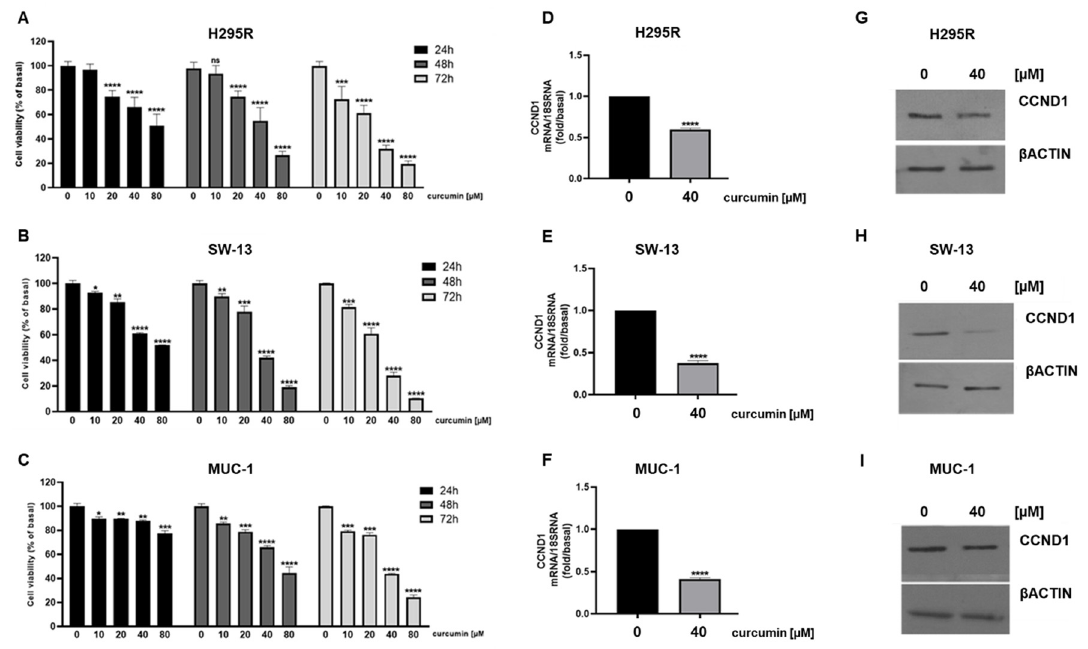
Figure 1. Curcumin reduces ACC cell viability. H295R ( A ), SW ‐ 13 ( B ) and MUC ‐ 1 ( C ) cells were treated with increasing doses (0, 10, 20, 40, 80 μ M) of curcumin for 24, 48 and 72 h. Cell viability was evaluated by MTT assay. Results are expressed as mean ± SE of three independent experiments (* p < 0.05; ** p < 0.01; *** p < 0.001; **** p < 0.0001; ns: not significant). ( D – I ) Cells were treated for 24 h with curcumin. CCND1 mRNA expression was assessed by real ‐ time RT ‐ PCR. Data are the mean ± SE of values from at least three RNA samples (**** p ‐ value < 0.0001 vs. calibrator). ( G – I ) CCND1 protein expression was detected by Western blotting (WB); β Actin was used as a loading control. Representative WB images of three independent experiments for each cell line are